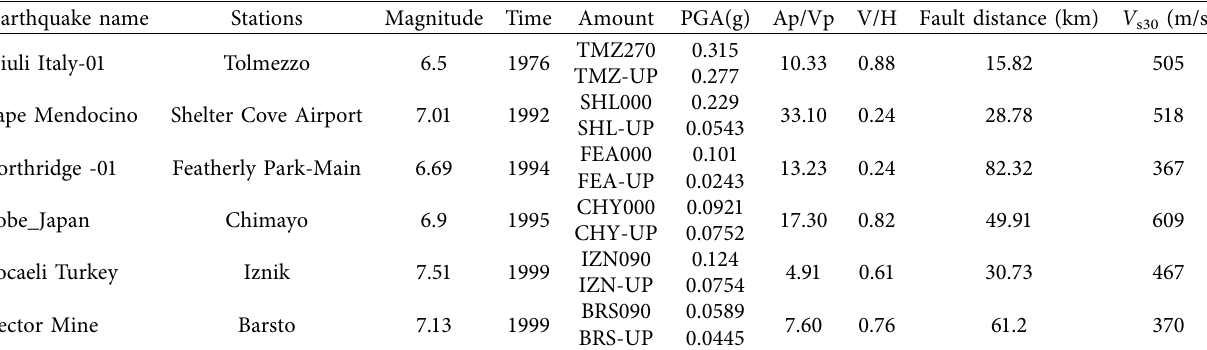
Table 3: Far-fault general earthquake information sheet.